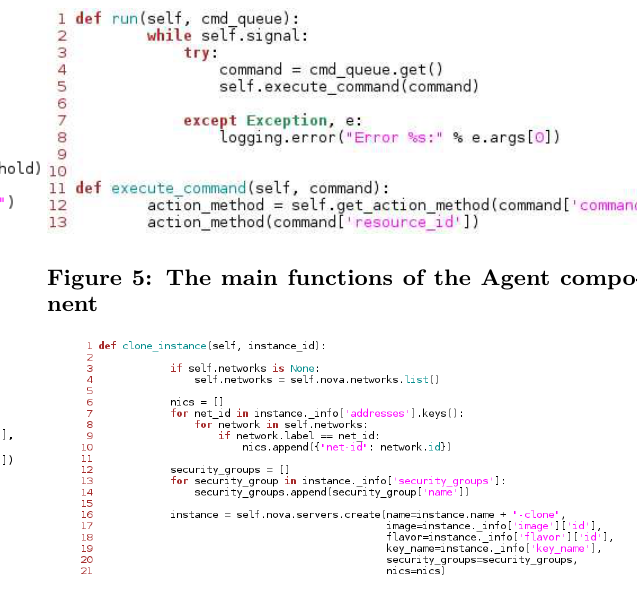
Figure 6: The Manager component: the function to clone a